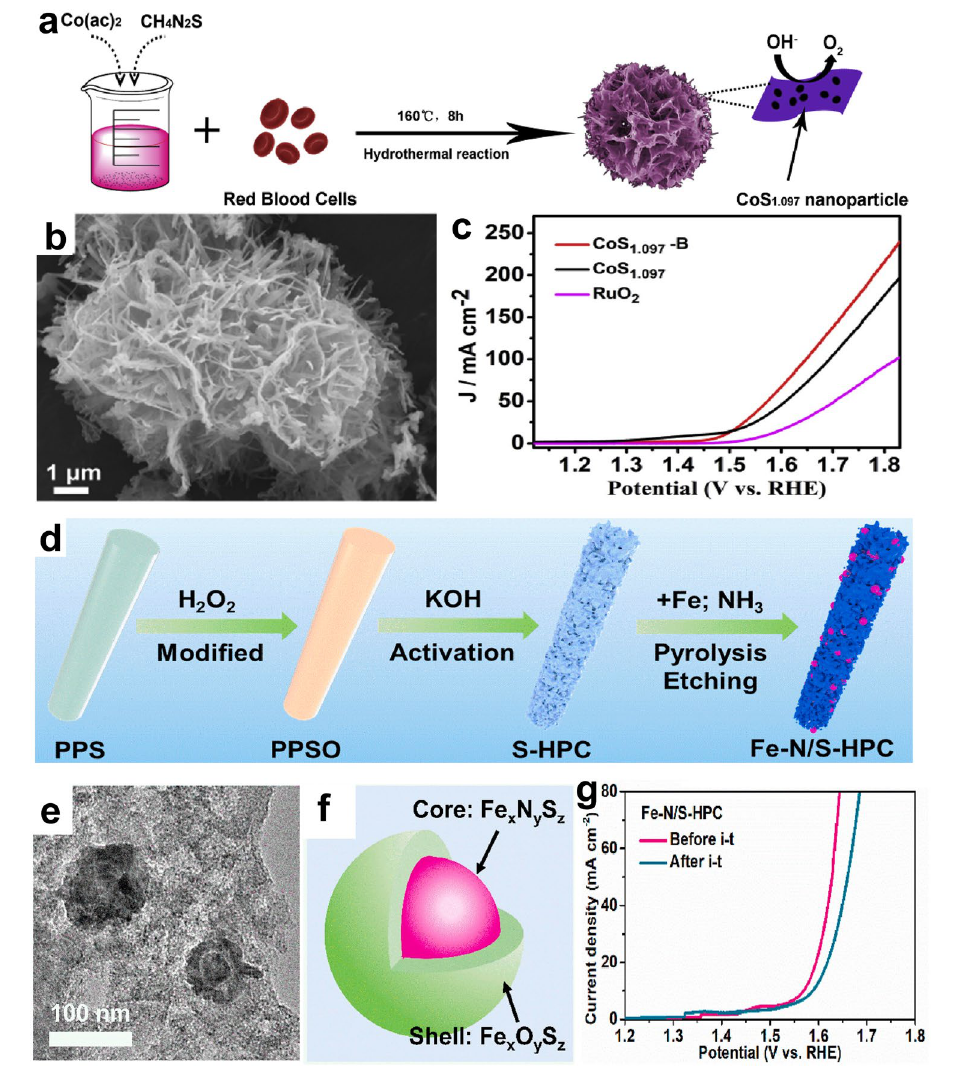
Fig. 11 a Schematic of the fabrication of CoS 1.097 ‑B catalyst. b SEM image of CoS 1.097 ‑B catalyst. c LSV curves of catalysts in 1.0 M KOH [167]. Copyright 2020, Elsevier. d Scheme of Fe–N/S‑HPC preparation from polyphenylene sulfide (PPS) plastic. e Transmission electron microscopy (TEM) image of Fe–N/S‑HPC. f A model of Fe‑based nanoparticles in Fe–N/S‑HPC. g LSV curves of Fe–N/S‑HPC before and after the 15 h OER durability test [169]. Copyright 2022,